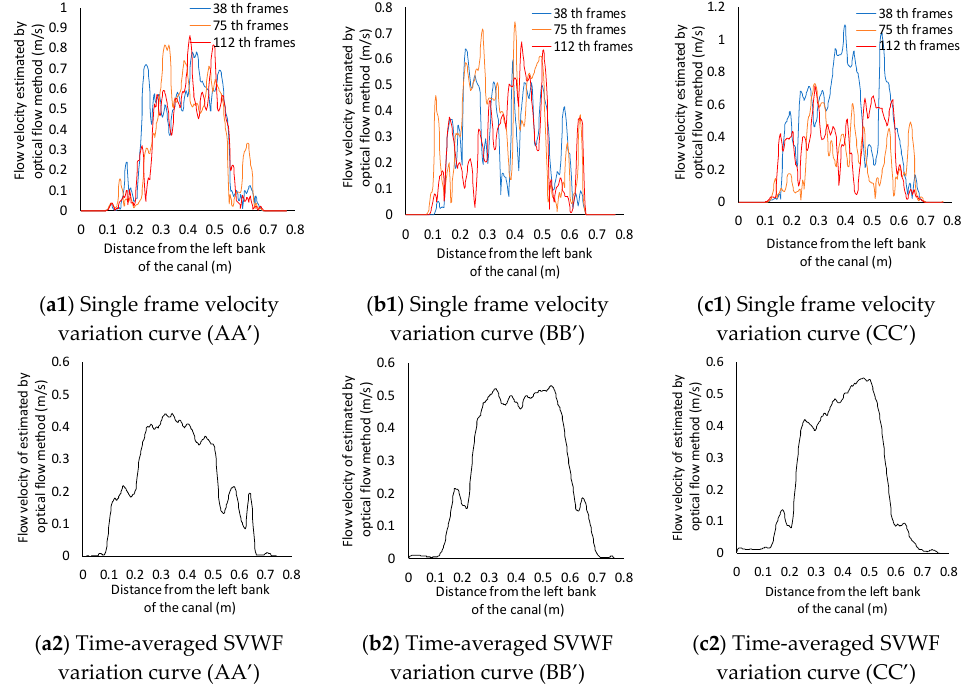
Figure 5. Single frame SVWF variation curves and corresponding time-averaged SVWF variation curves of AA’, BB’ and CC’.